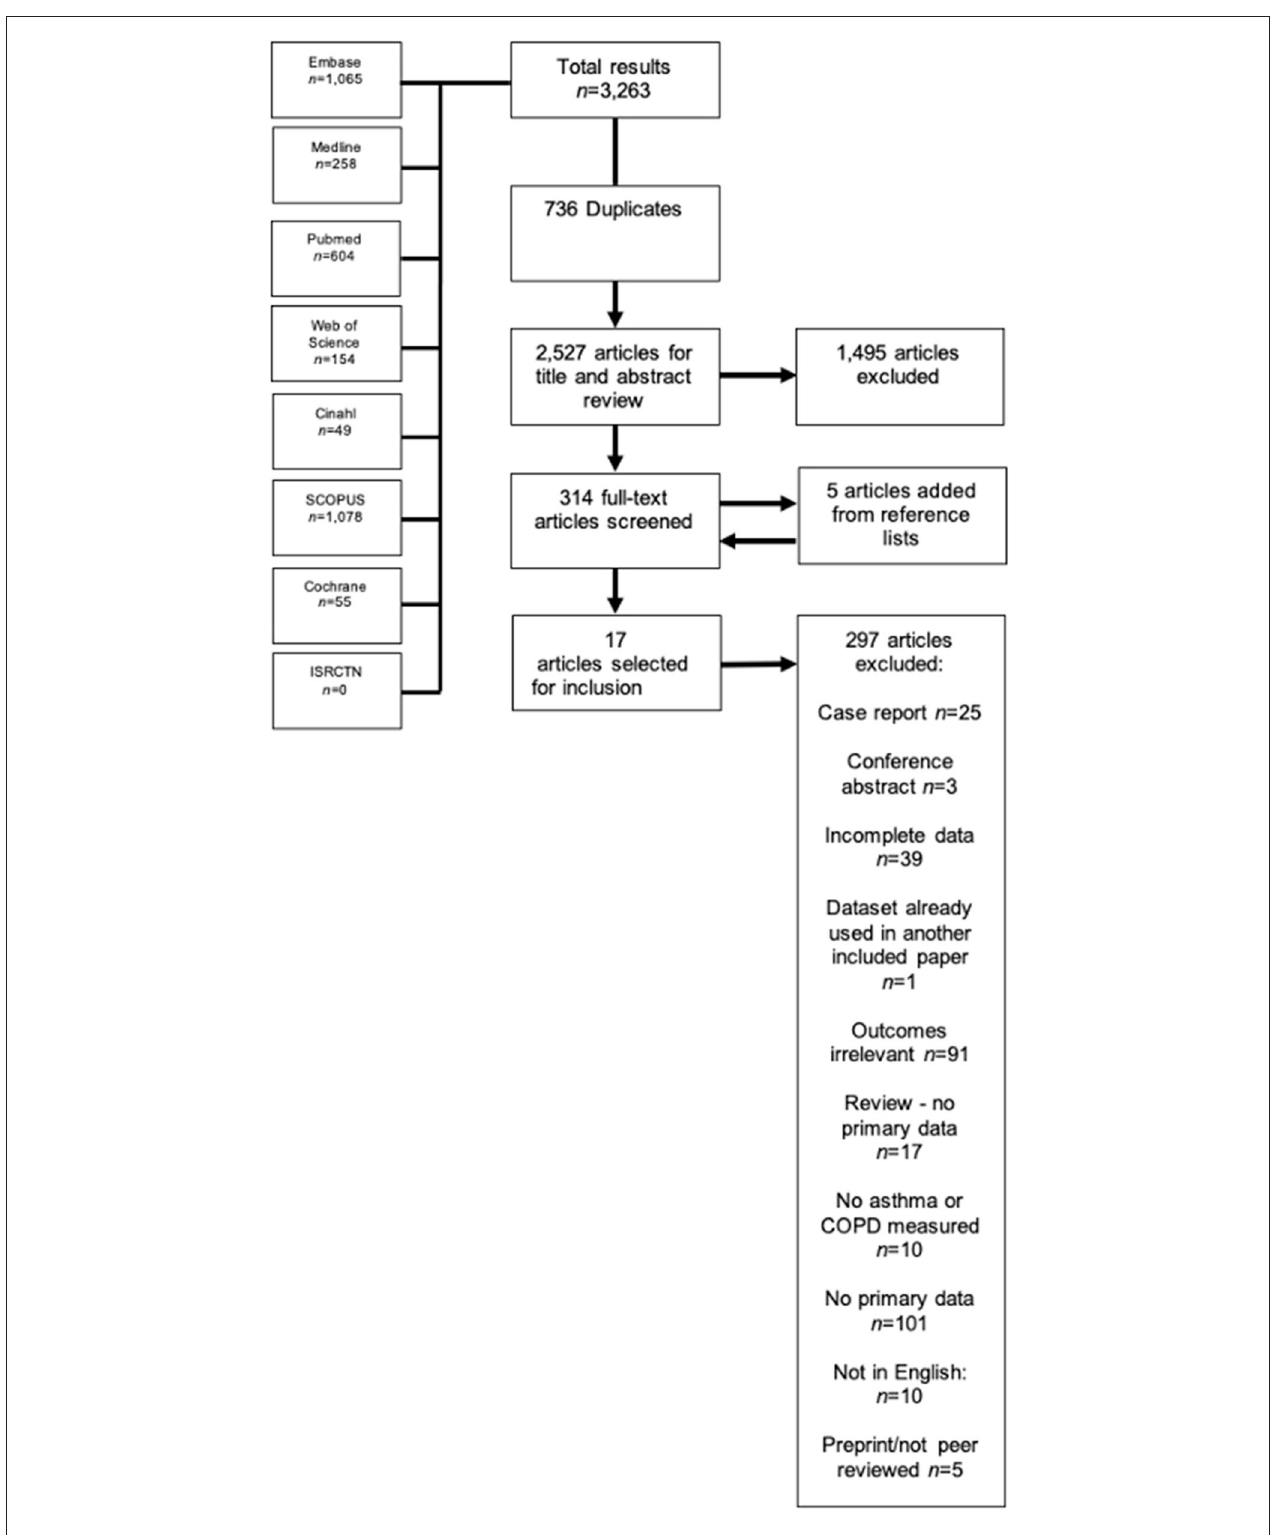
FIGURE 1 | PRISMA flowchart of included